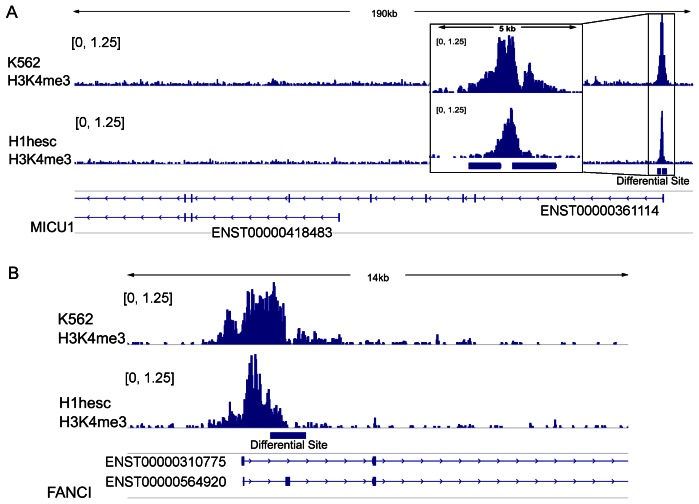
IGV [34] genome browser screenshots of two example genes that contain alternative promoter usage and alternative splicing events.The top two tracks are normalized genomic coverage of H3K4me3 in K562 and hESC cell lines. They are overlaid by diffReps-specific sites shown as solid bars. The bottom track is the gene model with two representative isoforms. (A) Gene MICU1 contains alternative promoter usage between two isoforms. The inset is a magnified figure of the differential sites at TSS; (B) Gene FANCI contains alternative splicing with a variant exon being preferentially included in K562 vs. hESC.